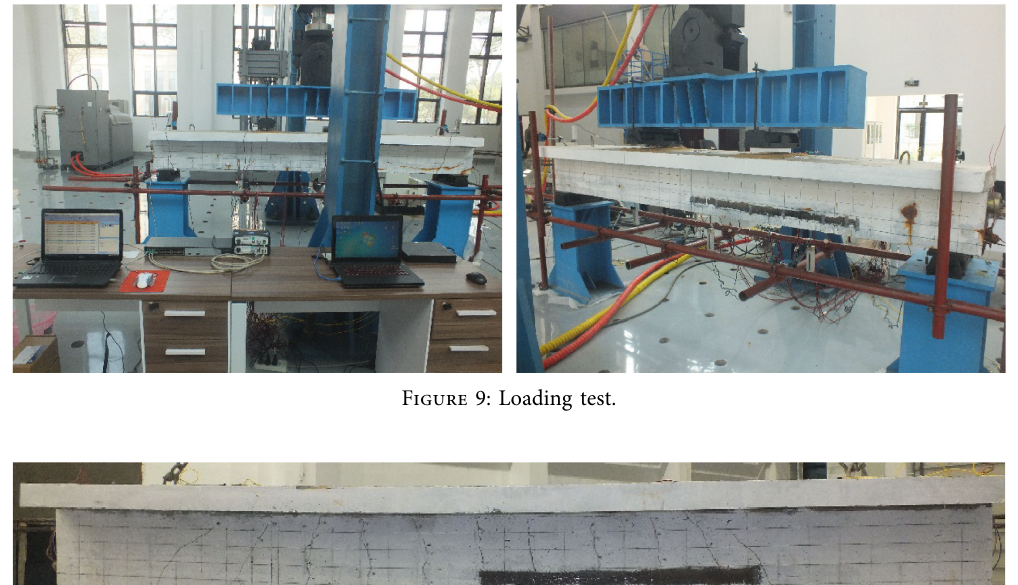
Figure 10: Distribution of 0P10